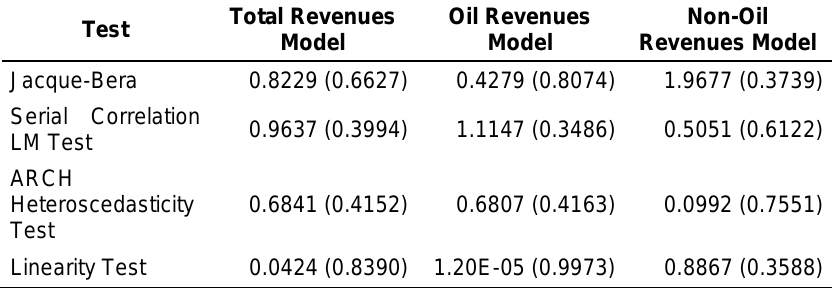
Table 7. Sensitivity/Diagnostic Tests